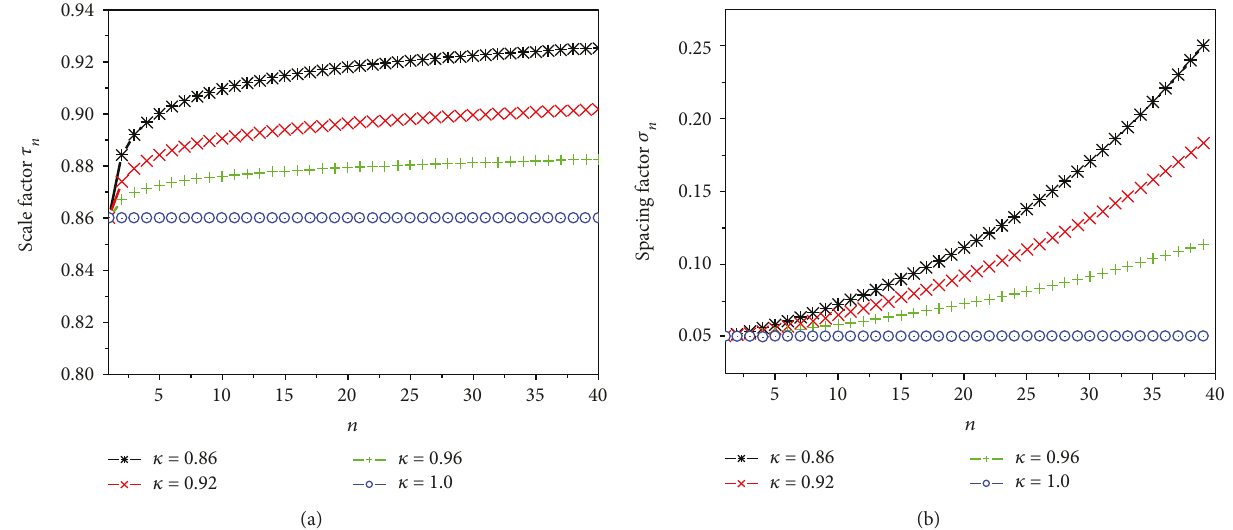
= 0 86 ) and (b) spacing factor 0